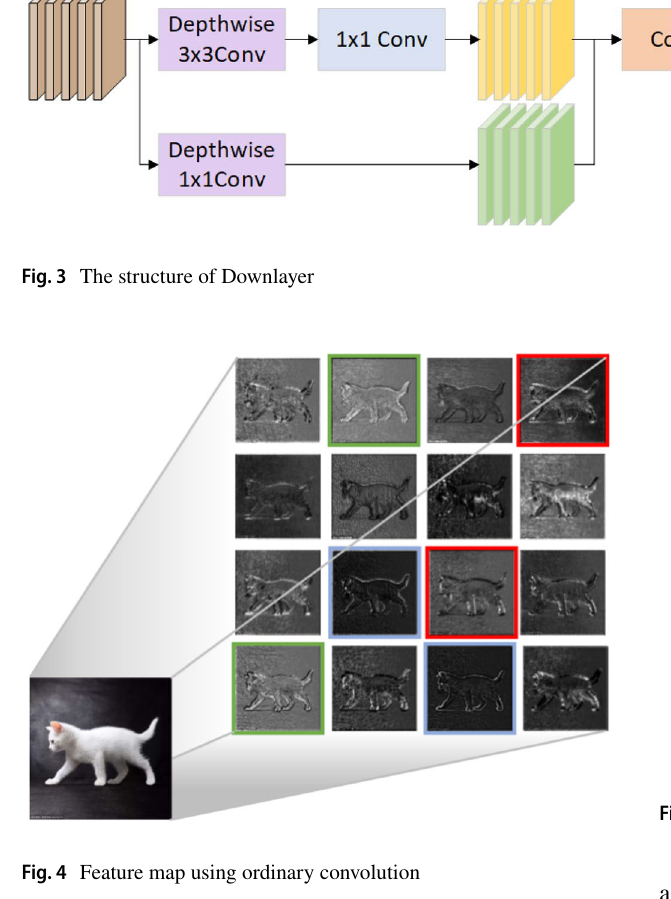
Fig. 4 Feature map using ordinary convolution